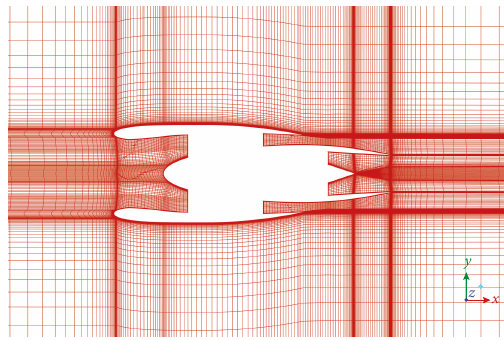
Figure 4: The symmetry surface grid of NAL-AERO-02-01. Table 1: NAL-AERO-02-01 computation